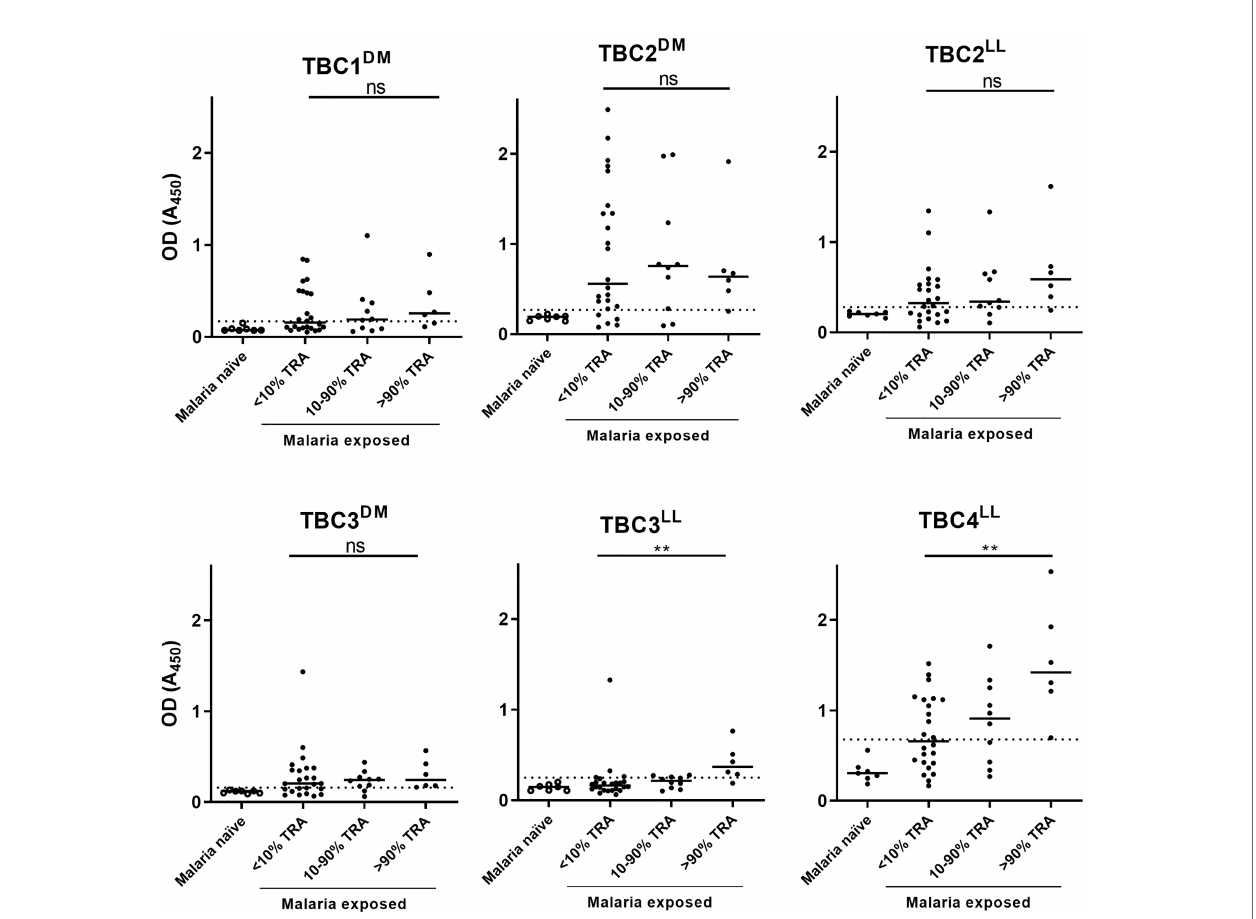
FIGURE 2 | Recombinant proteins show immunoreactivity with plasma samples from individuals living in malaria-endemic areas. Forty malaria-endemic and 7 malaria-naïve plasma samples were analyzed in antigen ELISAs against the respective immunogen indicated. Malaria-endemic samples are categorized based on their transmission reducing activity (TRA) as determined by Stone et al. (16). Optical density (OD) values are reported as individual raw absorbance measurements at 450nm with the median shown as bar. The dotted line represents the mean + 3*SD of the malaria-naïve plasma samples. Samples with OD values above this cut-off are considered positive. DM: Drosophila melanogaster , LL: Lactococcus lactis . Comparison between the <10% and >90% TRA samples was performed using the Mann-Whitney test (**<0.005, ns, not signi fi cant).